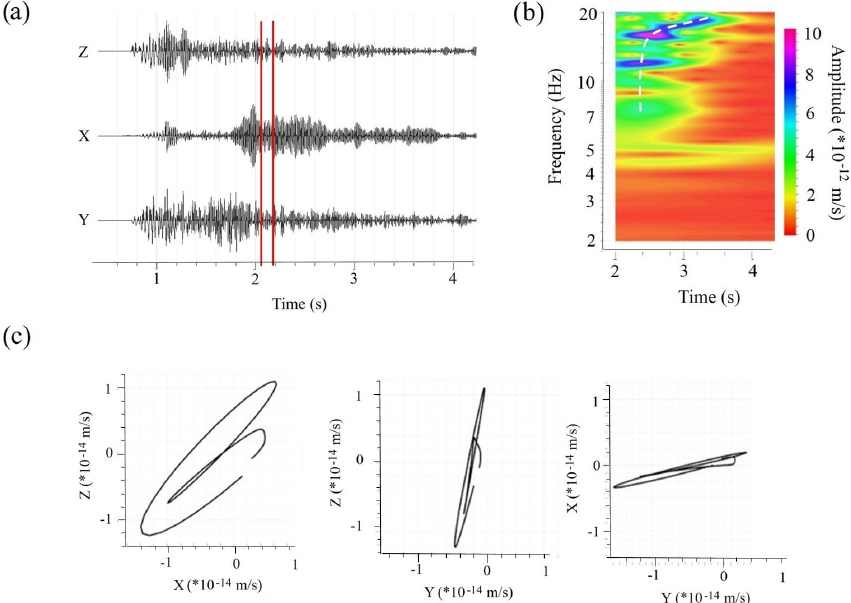
Figure 5. Result of analysis of scattered arrivals in synthetic seismograms with an apparent velocity of 2100–2500m/s for frequencies 2– 20Hz (Fig. 4): (a) 3C seismogram for synthetic receiver located at distance of 2000m from the source (Fig. 4); (b) spectrogram of the scattered arrival, recorded by the vertical component of the synthetic receiver (dashed white line illustrates dispersion properties of the scattered arrival); (c) particle motion diagrams, calculated using part of seismogram indicated by red lines in panel (a) , which corresponds to scattered